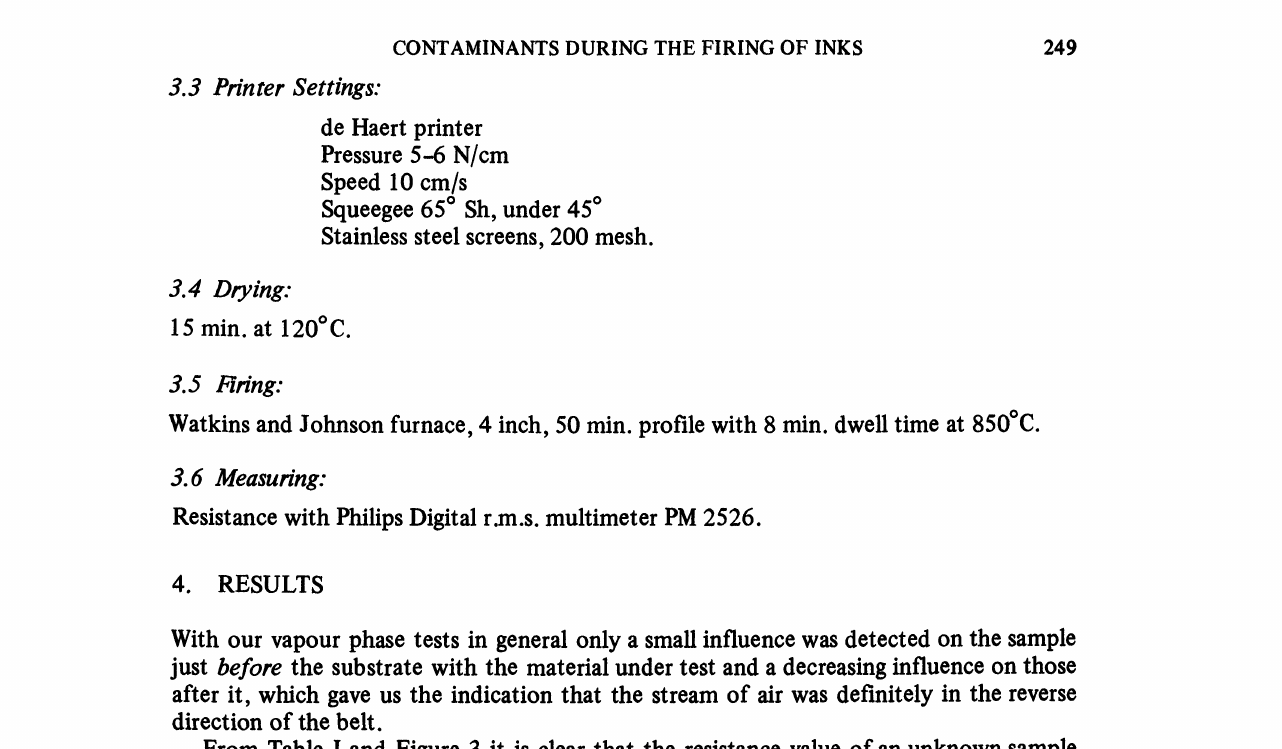
TABLE Reproducibility of printing resistors (DP 1361) in one series.